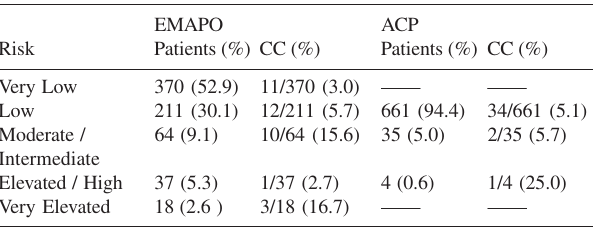
Table 2 - Risk level classification and